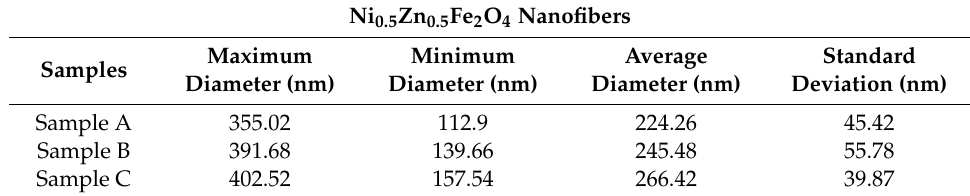
Table 4. Maximum, minimum, and average diameters, and standard deviations of Ni 0.5 Zn 0.5 Fe 2 O 4 nanofibers measured from samples A, B, and C.